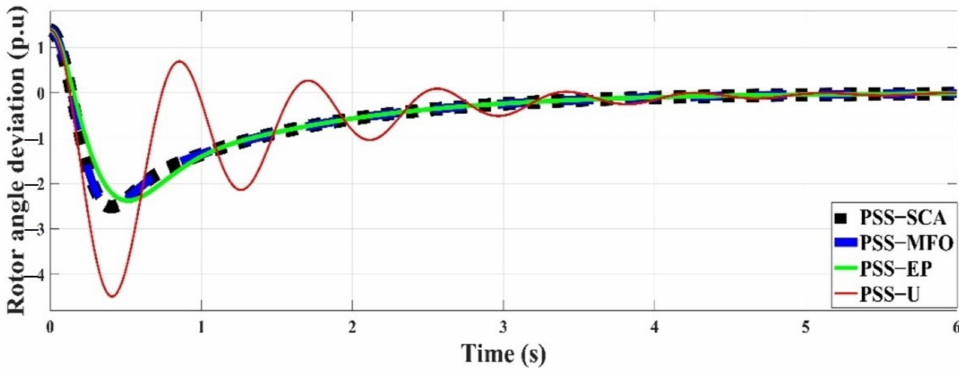
Figure 9. Rotor angle deviation for loading condition 2 of the SMIB with PSS.